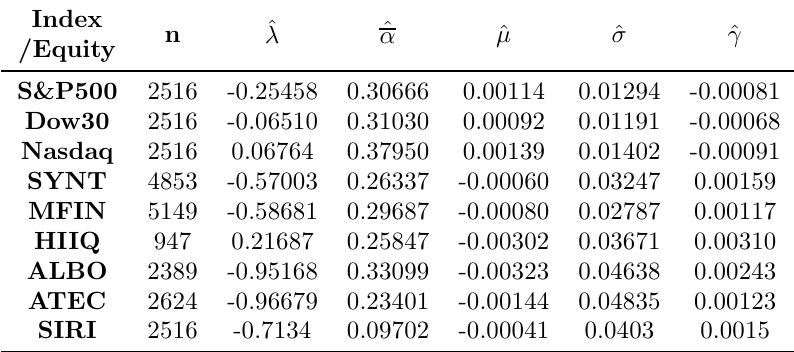
MLE for Generalized Hyperbolic distribution